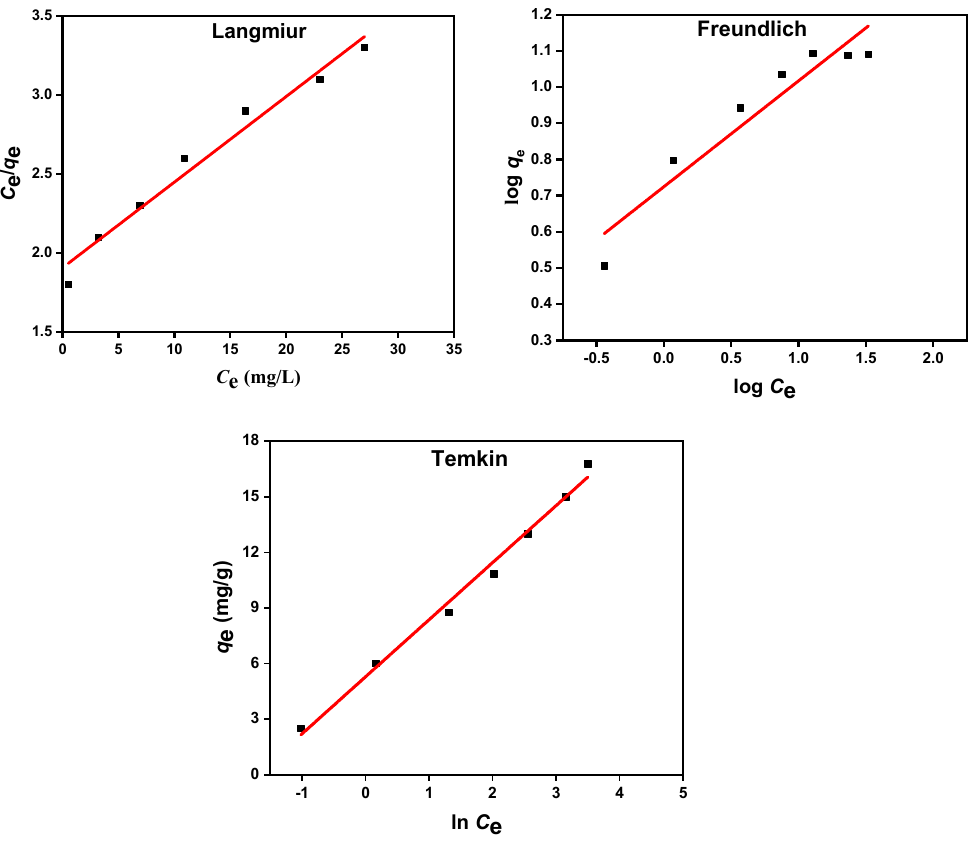
Figure 9. Effect of initial concentration of diazinon on removal process at pH = 7, contact time = 40 min, adsorbent dosage = 0.5 g/L, temperature = 22 °C, and agitation speed = 300 rpm.